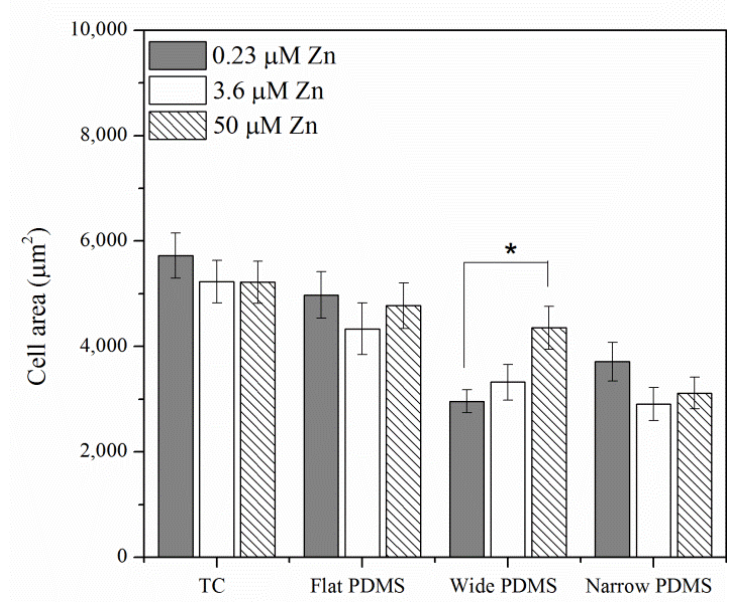
Figure 3. Cell spreading area computed from fluorescence micrographs in Figure 2A–D. A single asterisk ( * ) indicates a p < 0.01 level of significance.